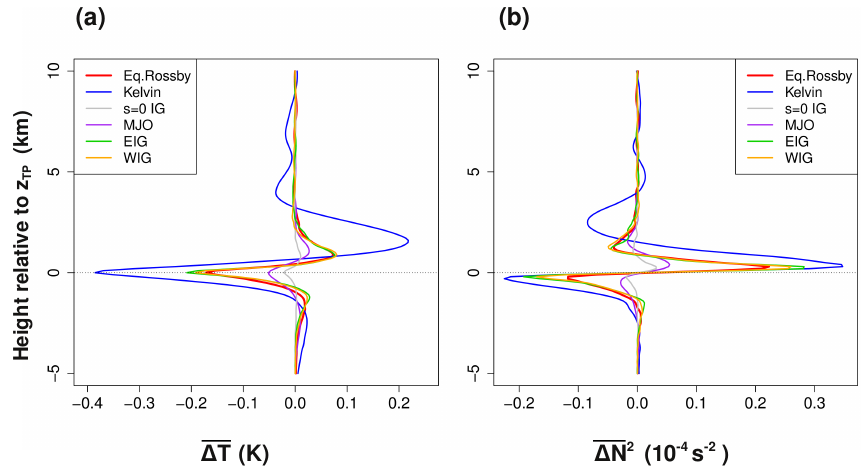
Figure B1. Summer (JJA) average signature of the different wave types, as the mean anomalies of (a) temperature (cid:49)T and (b) static stability (cid:49)N 2 in the equatorial zonal-mean vertical profiles (10 ◦ S–10 ◦